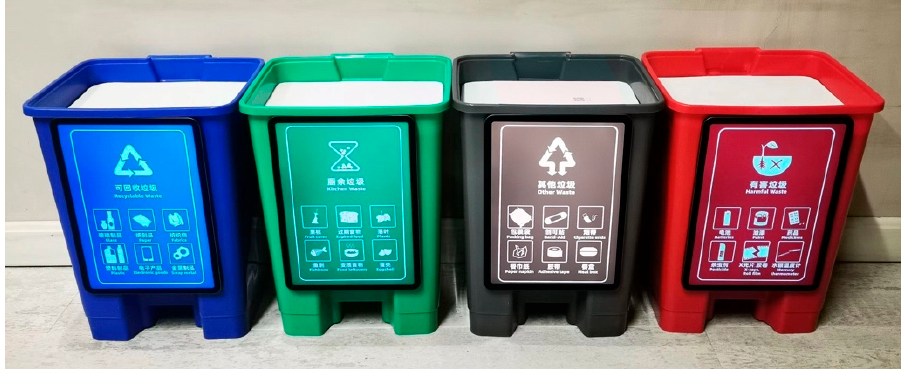
Figure 2. The designed intelligent trash can system toy.